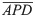
Variation of APD¯ and ω¯ with various ionic cunductances.Plots of APD¯ and ω¯ versus g; here, APD¯=APD/APDo and ω¯=ω/ω0, where APDo = 250 ms, and ω0 = 4.38 Hz are, respectively, the control values of APD and ω; (a1) and (a2) show, respectively, that APD¯ decreases with the conductances Gi, for the currents IKr, IKs, IK1, INa and INaK; however, it increases with increasing Gi, for the currents ICaL, INaCa and Ito; (b1) and (b2) show that the variation of ω¯, with the various channel conductances, is consistent with Eq (2).